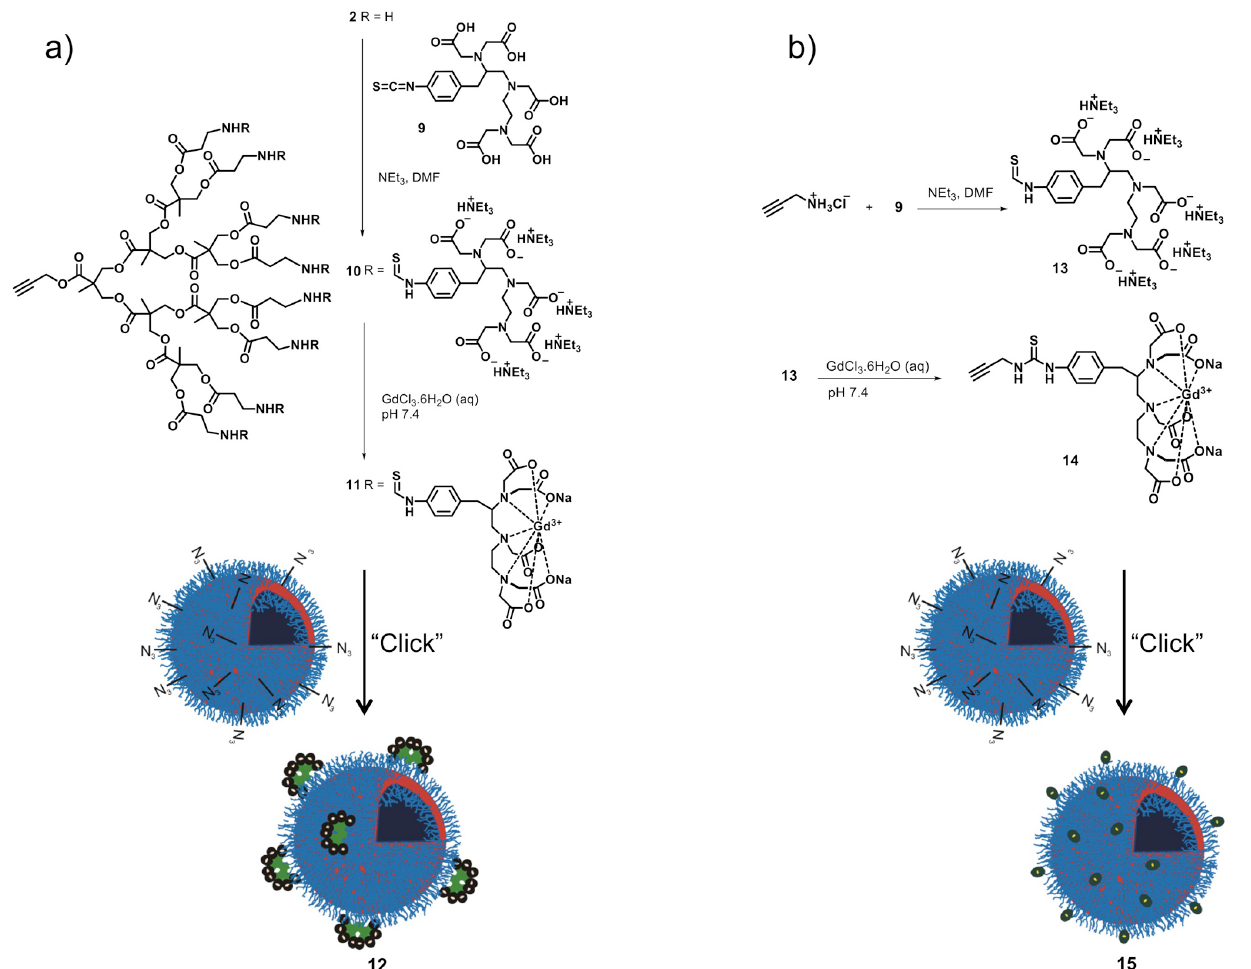
FIGURE 12 - Preparation of a) dendritic Gd(III) and dendritic Gd(III) functionalized polymersomes; b) non-dendritic Gd(III) and non-dendritic Gd(III) functionalized